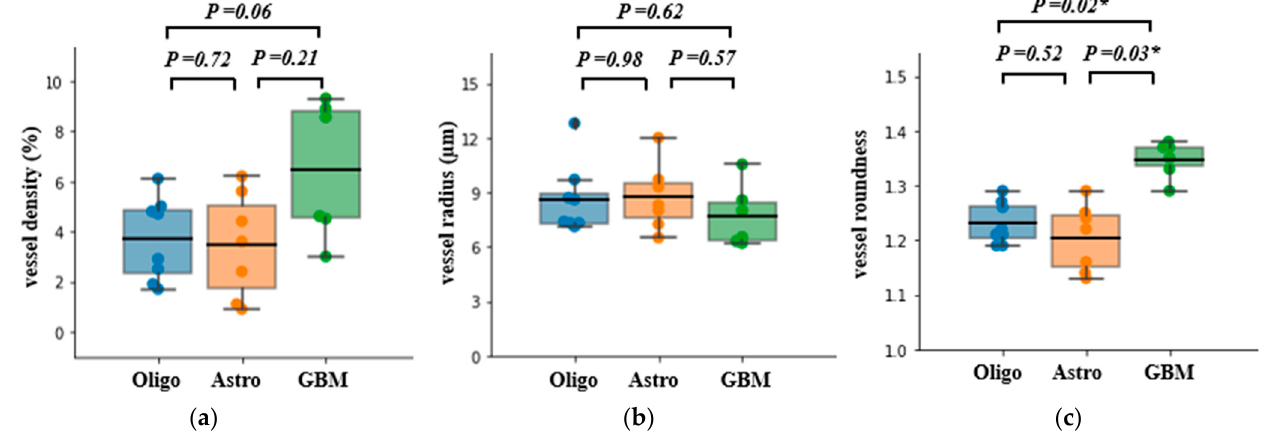
Figure 4. Box plot of histology-derived measurements: ( a ) vessel density, ( b ) vessel radius, and ( c ) vessel roundness, with mean bar for the three glioma subtypes Oligo (IDH-mut &1p/19q codeleted), Astro (IDH-mut), and GBM (IDH-wt). Tukey honestly significant difference (HSD) test or Dunn’s test using a Bonferroni correction was used for pairwise statistical analysis. ‘*’ indicates a significant difference between two subtypes accompanied by the exact p -value.